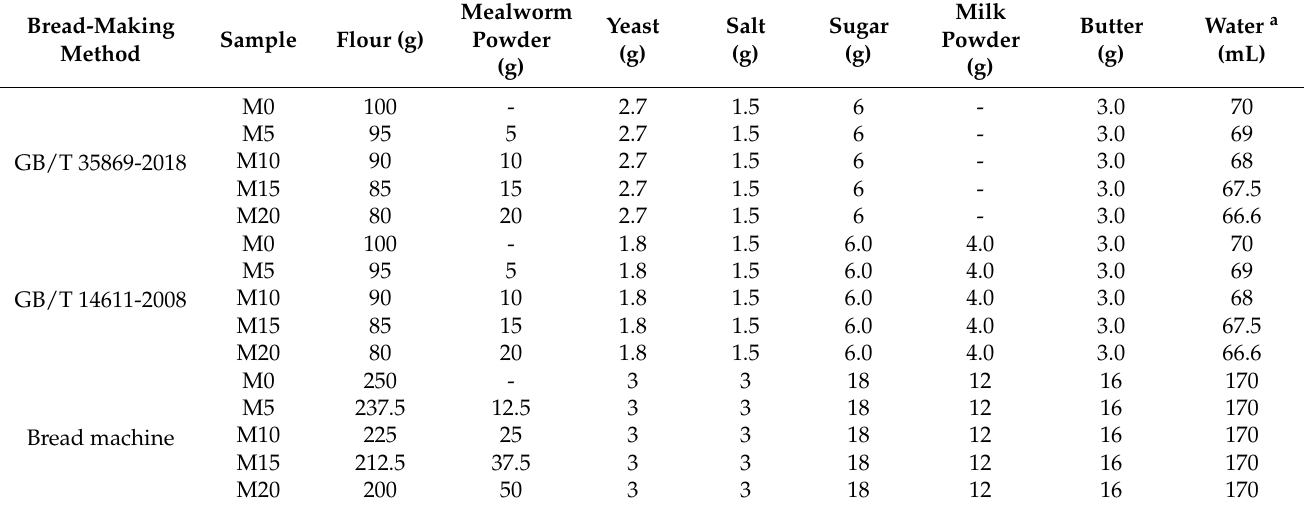
Table 1. Formulas for bread-making methods with added mealworm